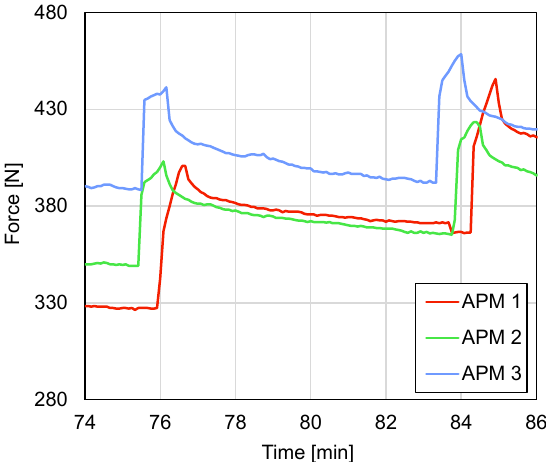
Figure 7. Loading curves of the preliminary tests (light-grey colour) and the three samples subjected to the time-lapse XCT imaging. The force decreases apparent in the curves were caused by the material relaxation during each CT scan.